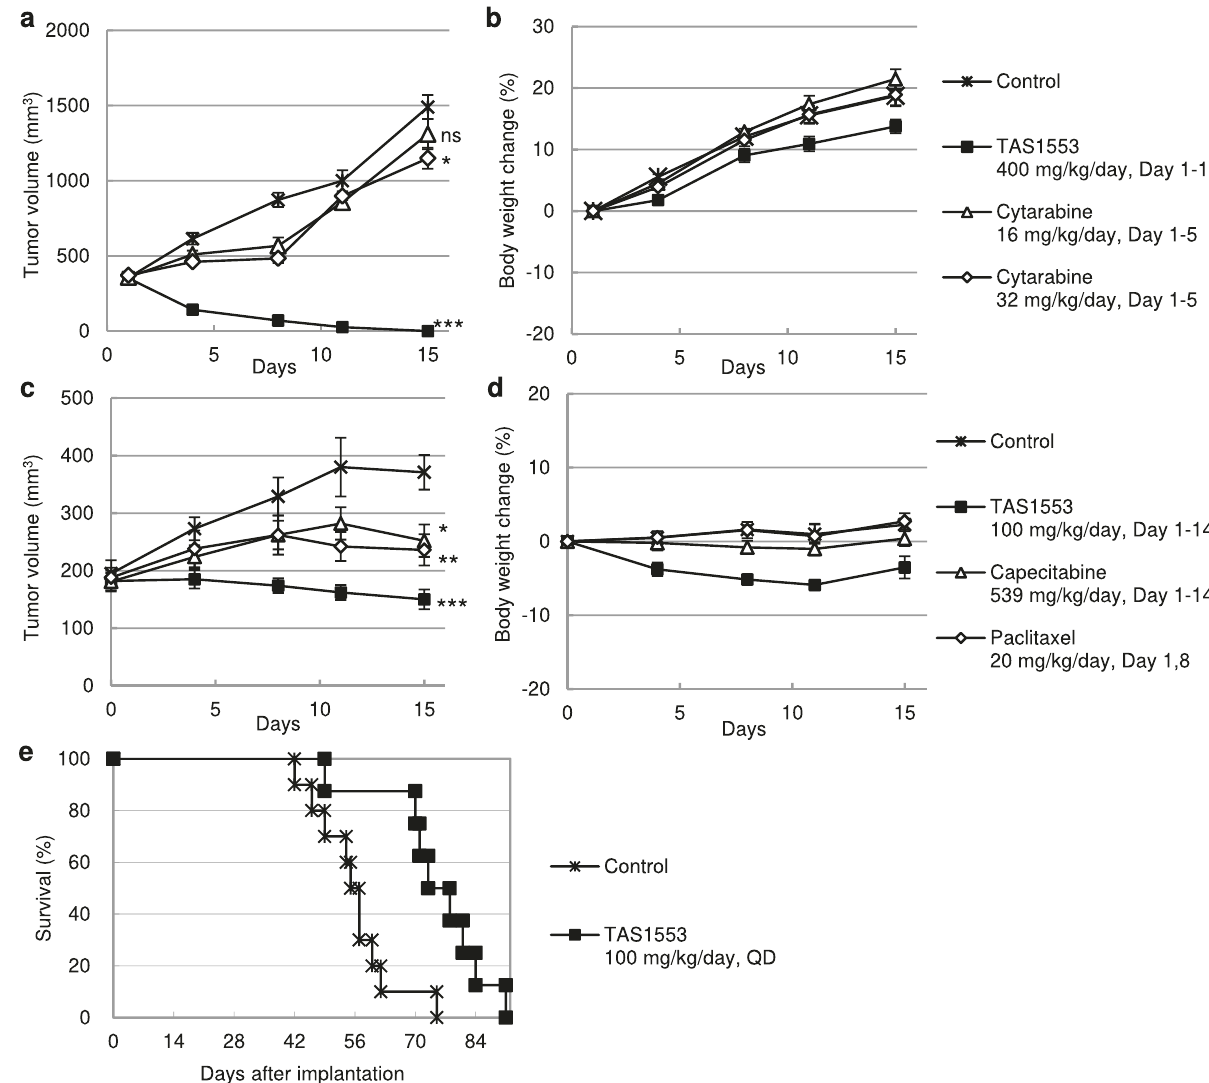
Fig. 5 Anti-tumor effect of TAS1553 in multiple models. a , b Inhibition of tumor growth ( a ) and body weight change ( b ) in rats bearing MV-4-11 xenografts. TAS1553 was orally administered at 400mg/kg for 14 days, and cytarabine was administered intravenously at 16 or 32 mg/kg for 5 consecutive days (Day 1 – 5). Data are presented as the mean ± SEM ( N = 5). ns not signi fi cant. c , d Inhibition of tumor growth ( c ) and body weight change ( d ) in mice bearing HCC38 xenografts. TAS1553 and capecitabine were orally administered for 14 days once daily at 100 mg/kg and 539 mg/kg, respectively. Paclitaxel was administered intravenously once a week at 20 mg/kg. Data are presented as the mean ± SEM ( N = 6). e Survival bene fi t of daily oral administration of TAS1553 in the systemic model. Kaplan – Meier survival curve of mice inoculated with mice bone marrow cells harboring human MLL-AF9 fusion gene and Luciferase via the tail vein. Eleven days after implantation, mice were administered with vehicle ( N = 10) or TAS1553 ( N = 8) at 100 mg/kg once daily. * P < 0.05, ** P < 0.01, and *** P < 0.001 versus control group. ns not statistically signi fi